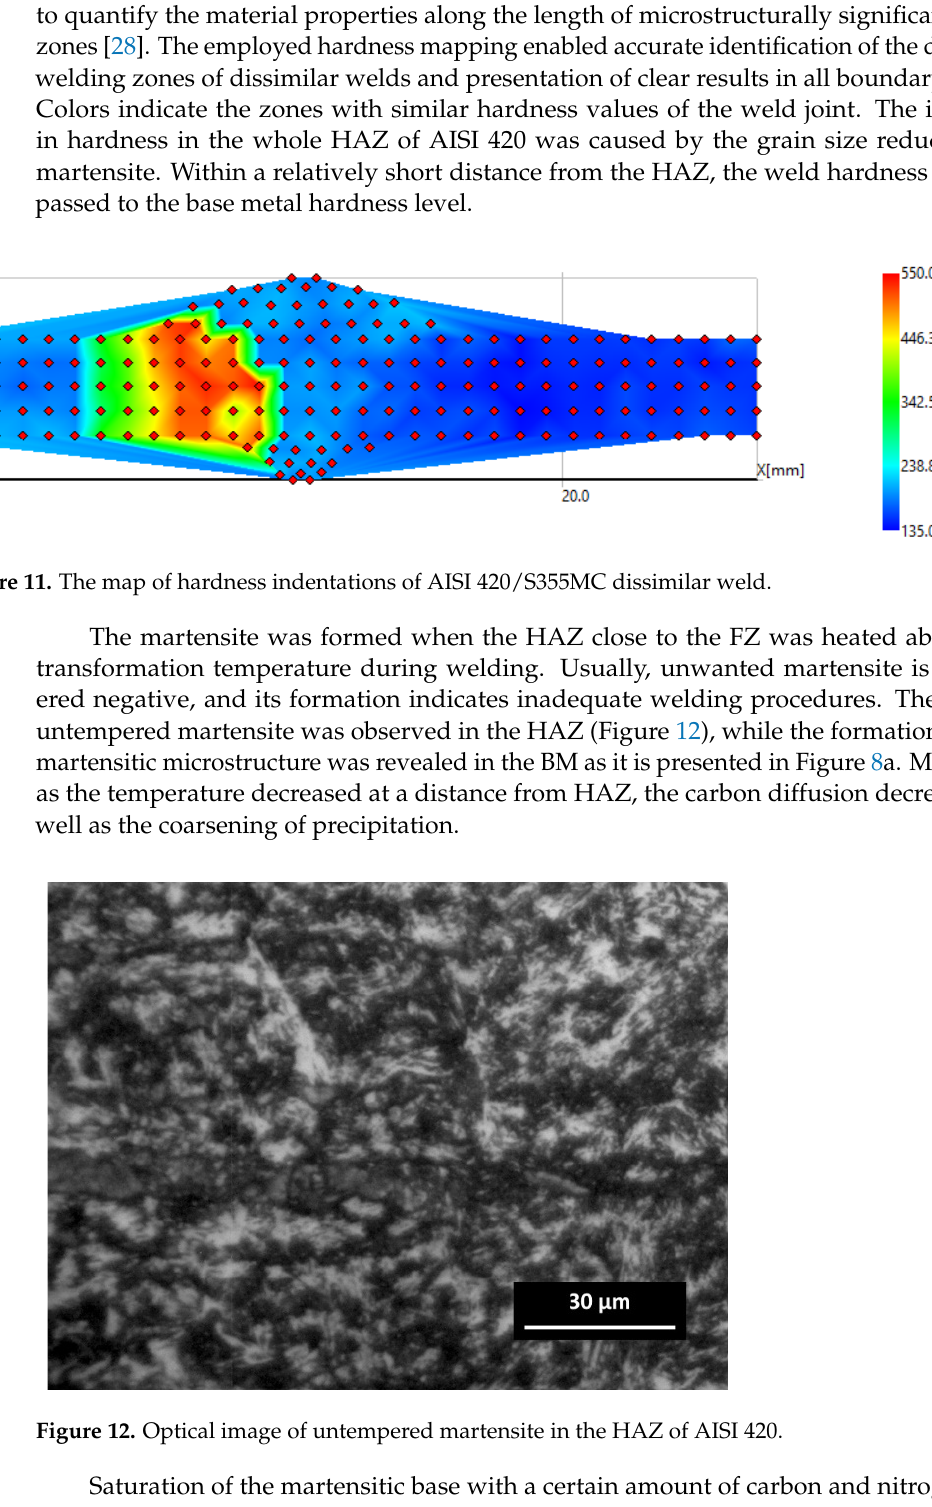
Saturation of the martensitic base with a certain amount of carbon and nitrogen can also cause the increase in hardness in this area: the hardness values ranged from 200 to 505 HV/0.1. It has been reported that a martensitic structure of high hardness generally has a low fracture toughness and is considered as highly susceptible to hydrogen-induced cold cracking compared with structures of lower hardness and higher fracture toughness